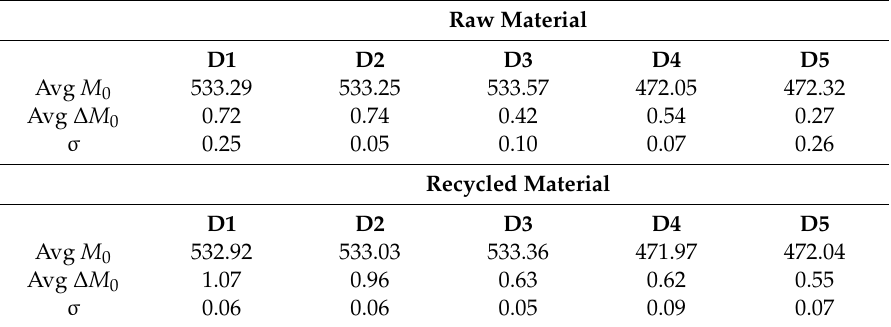
Table 2. Measurements (mm) at M 0